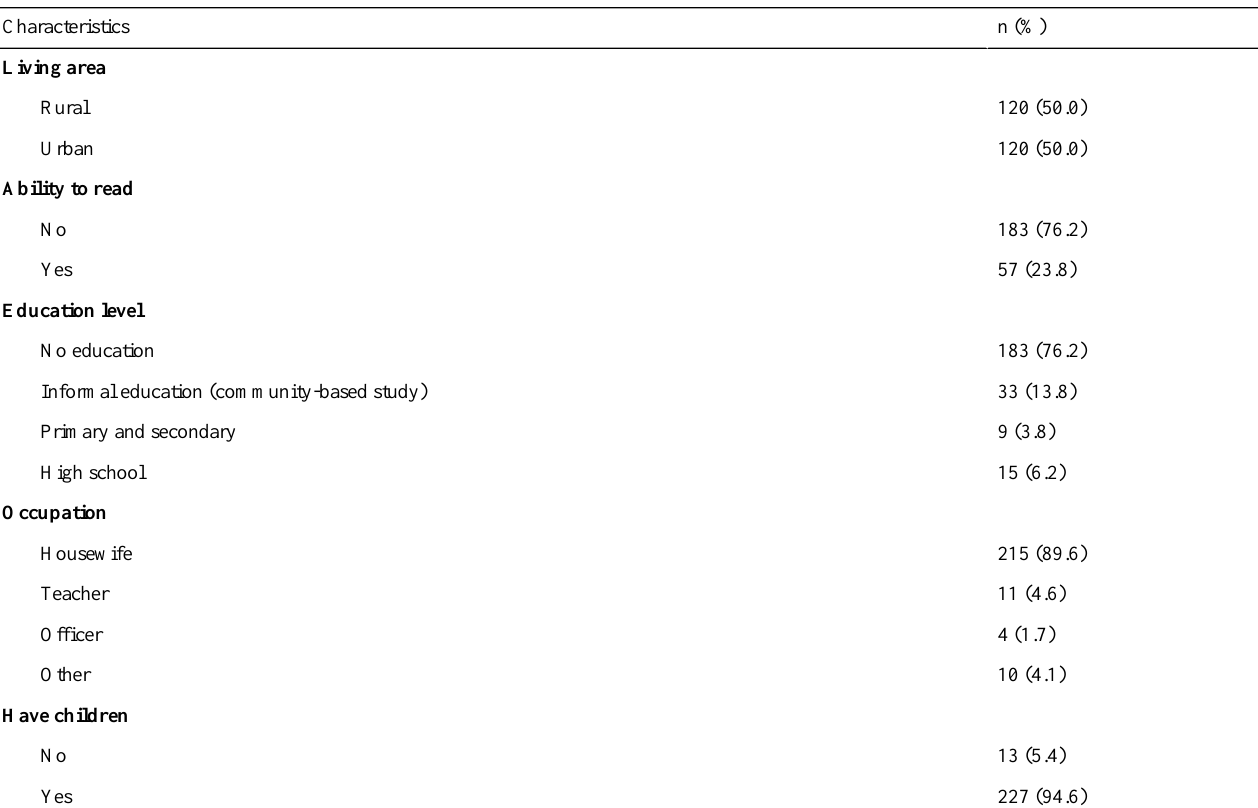
Table 1. Demographic characteristics of the study population